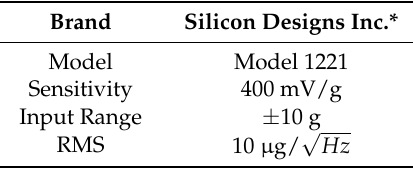
Table 1. MEMS accelerometers parameters.